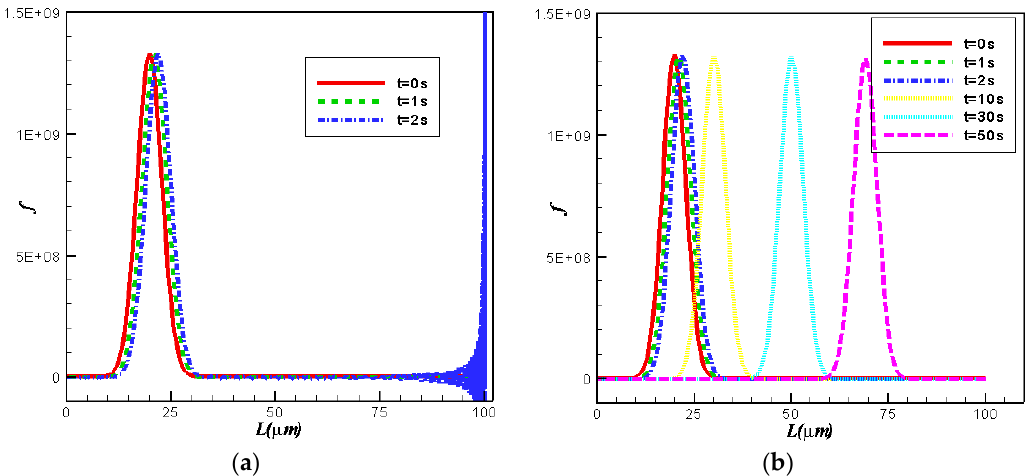
Figure 2. Comparison for numerical results with different coefficients of the diffusive term: ( a ) ε = 0; ( b ) ε = 0.002. Table 2. L 1 and L 2 errors for different coefficients of the diffusive term.